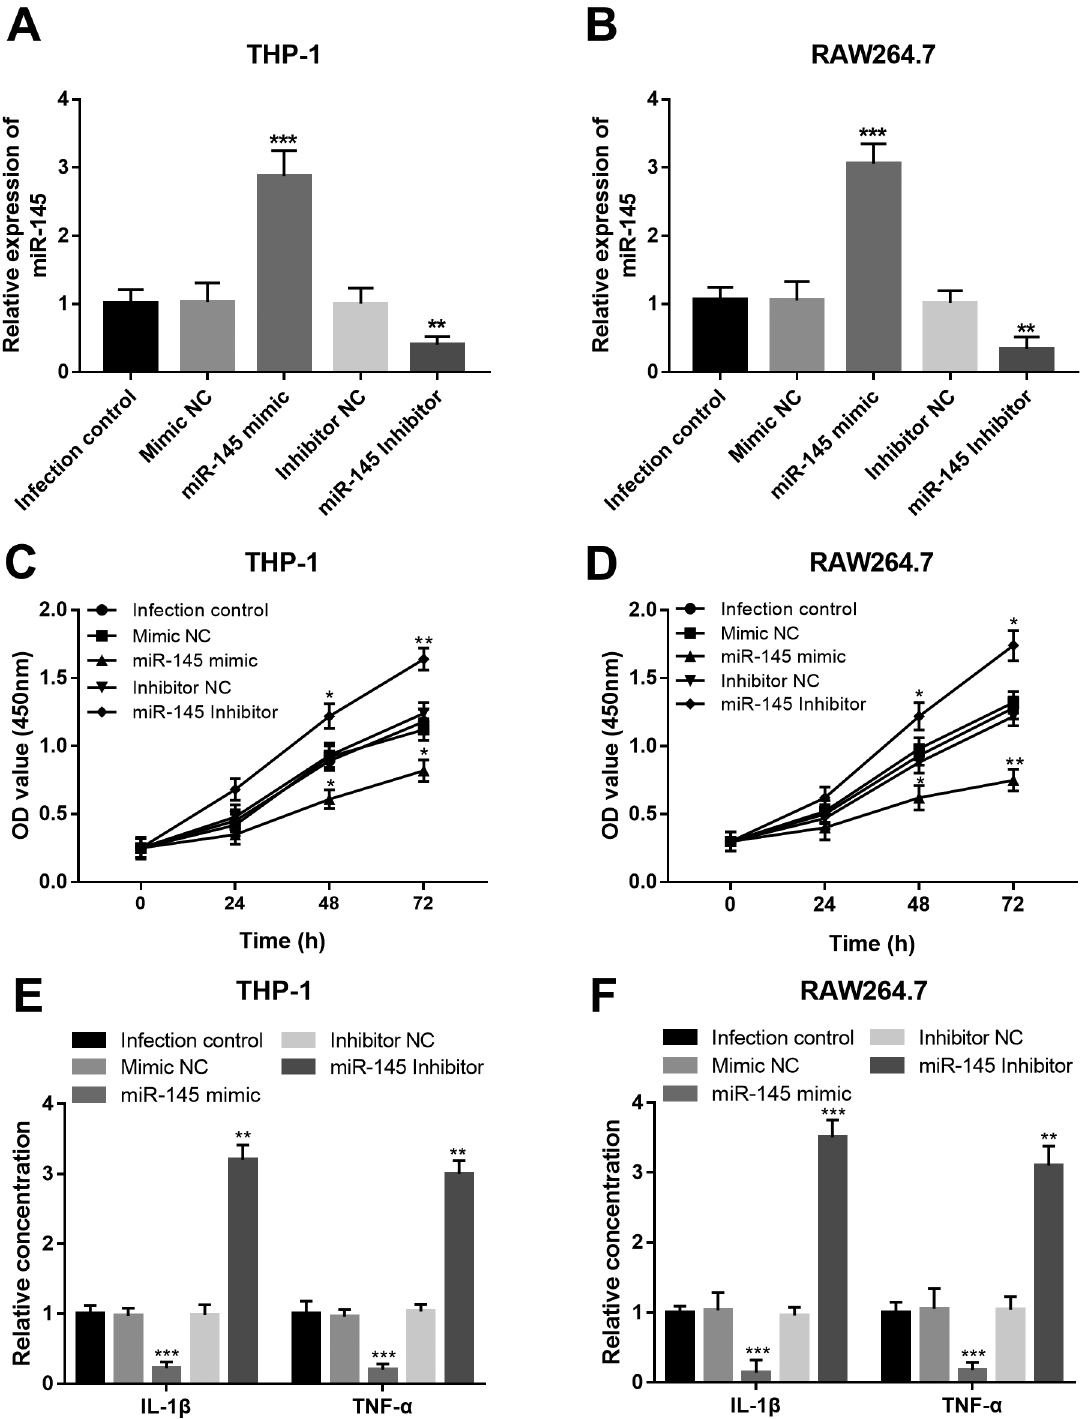
Figure 4 - Effects of miR-145 on the cell viability and inflammation in the macrophages upon Mtb infection. A and B. Expression of miR-145 was success- fullyregulatedinbothTHP-1andRAW264.7cells.CandD.TheoverexpressionofmiR-145couldsuppress,whereasthedownregulationofmiR-145could promotethecellviabilityofthemacrophages.EandF.TheconcentrationsofIL-1 (cid:2) andTNF- (cid:3) inthemacrophagesuponMtbinfectionwereinhibitedbythe upregulation of miR-145, but were enhanced by the knockdown of miR-145. * P < 0.05, ** P < 0.01, *** P < 0.001 vs. Infection